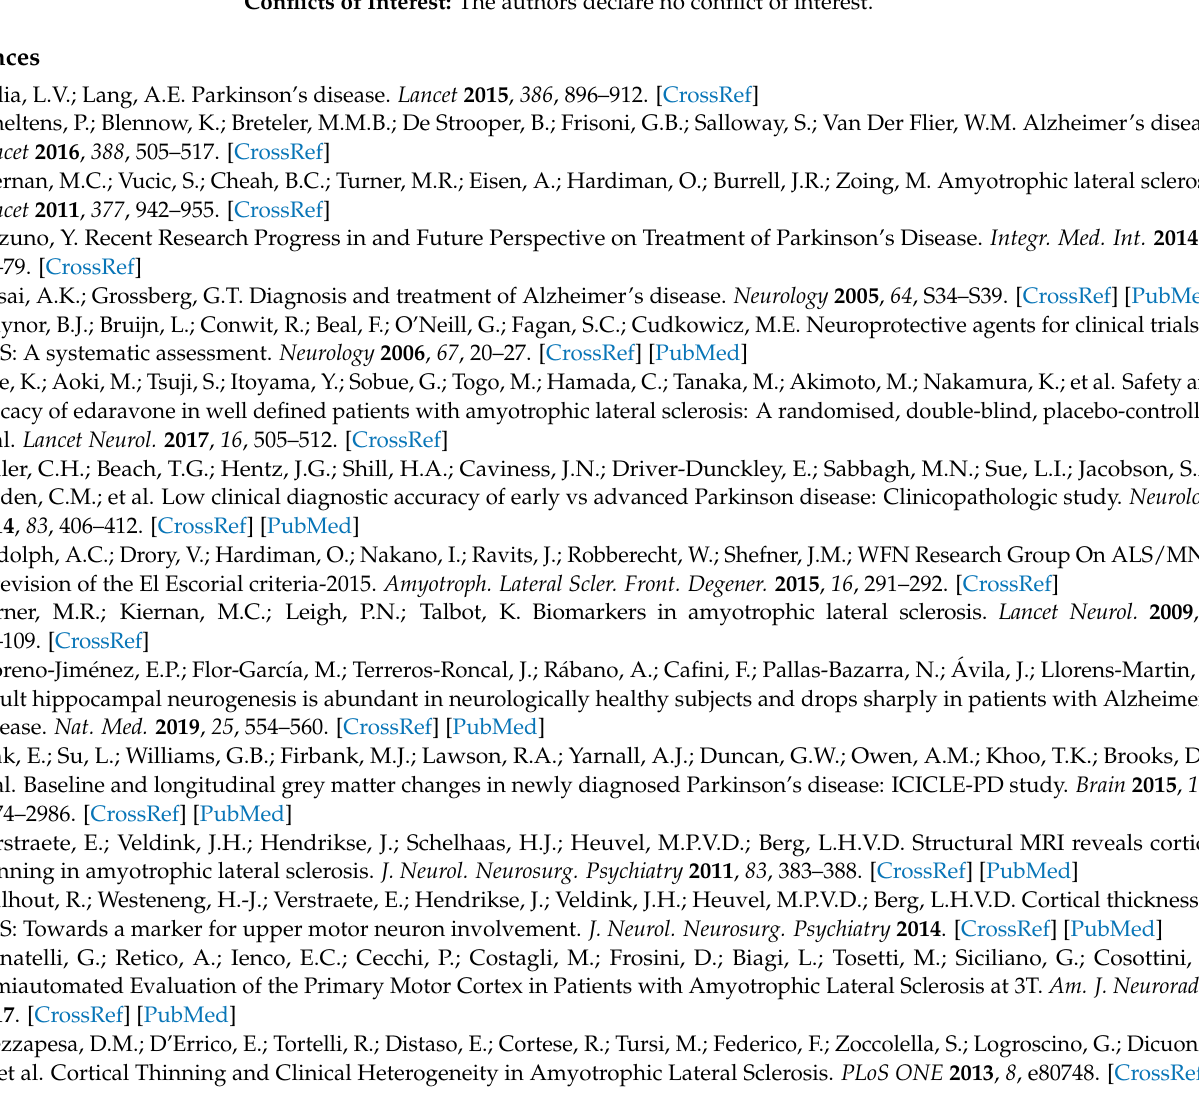
ROIs plotted versus age ( x -axis), Figure S2: Regional cortical thicknesses ( y -axis, in mm) measured from parietal ROIs plotted versus age ( x -axis), Figure S3: Regional cortical thicknesses ( y -axis, in mm) measured from temporal ROIs plotted versus age ( x